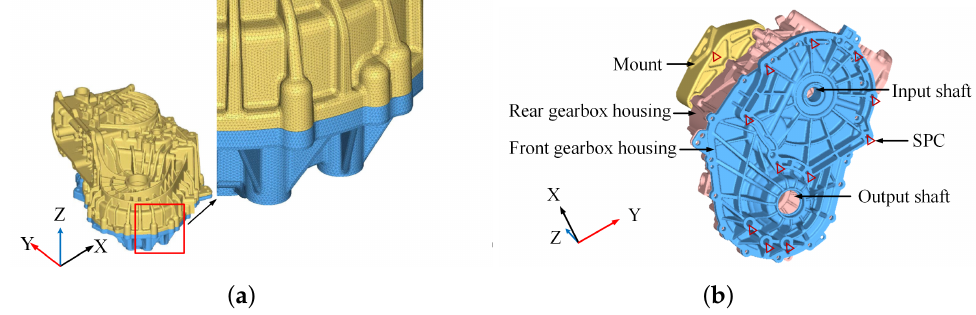
Figure 10. ( a ) Local mesh of finite element model. ( b ) Finite element model of gearbox housing.